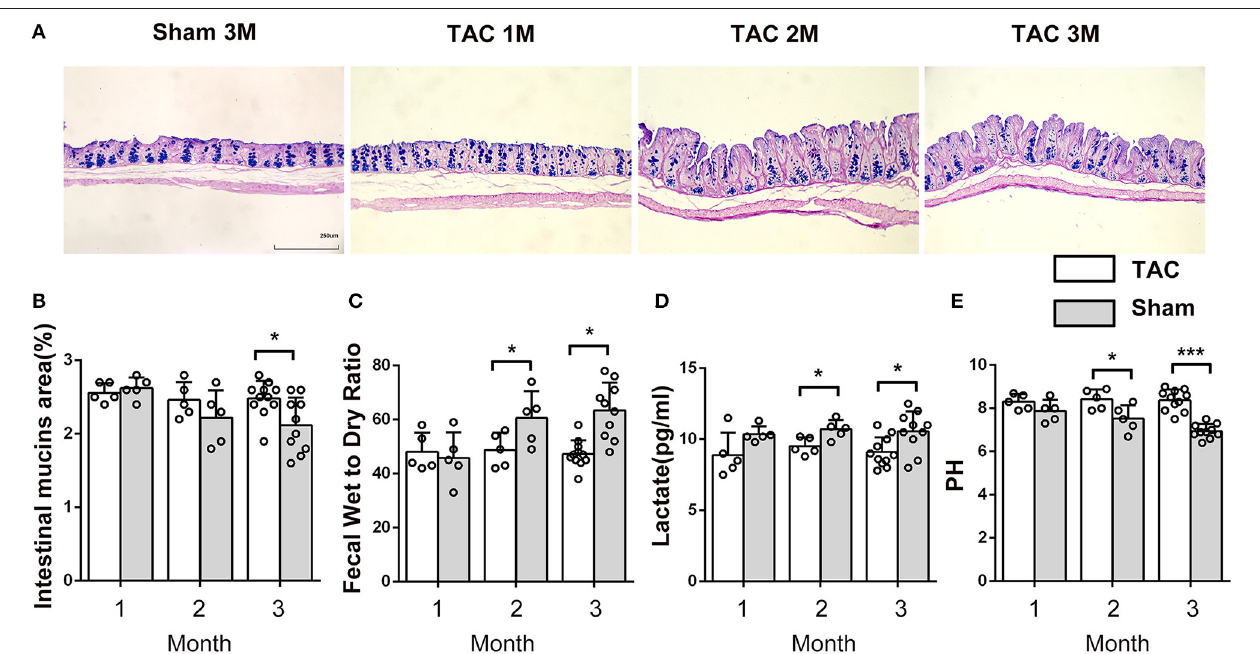
FIGURE 3 | The properties of the intestine and the feces changed after thoracic aortic constriction (TAC) surgery. (A) Cecum Alcian blue and periodic acid-Schiff (AB-PAS) staining. (B) Acid mucin relative area of the TAC and sham groups. (C) Fecal water content in the two groups after drying at 60 ◦ C for 12h. (D) Lactate level in feces. (E) pH of feces (100-mg fecal sample in 500 µ l of saline solution). n = 5–11. * p < 0.05, *** p <